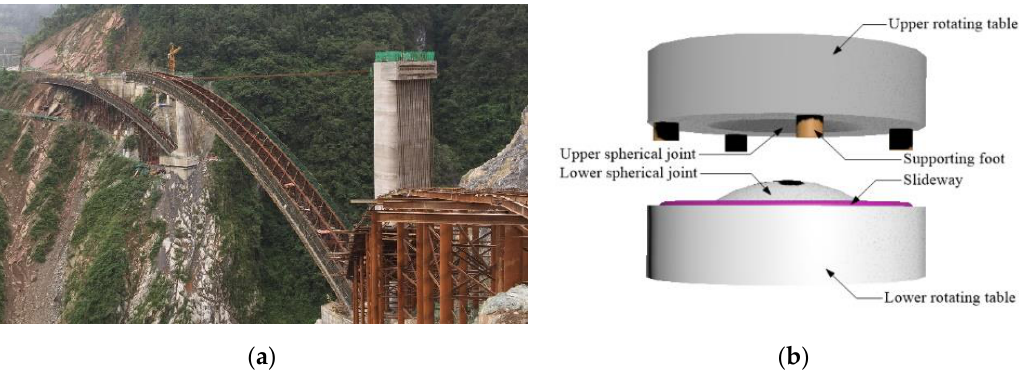
Figure 1. ( a ) Rotating system and rotating construction process; ( b ) spherical joint.